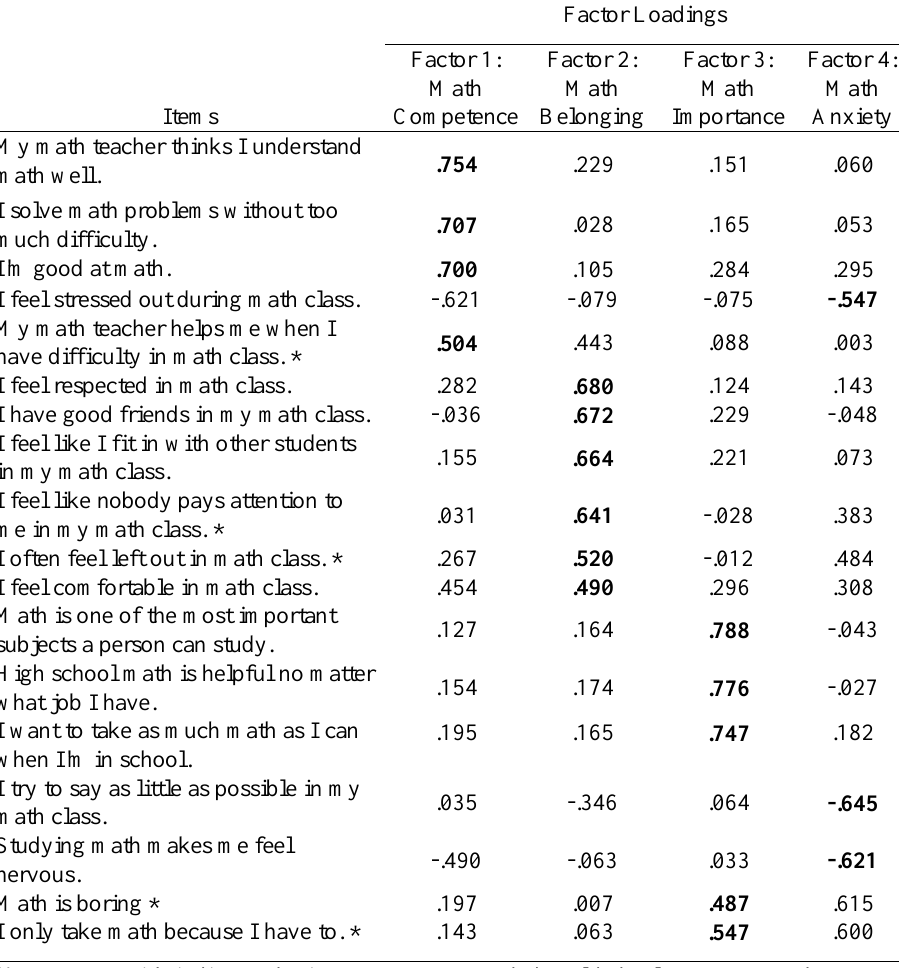
Rotated Component Matrix showing factor loadings for Attitudes toward Math